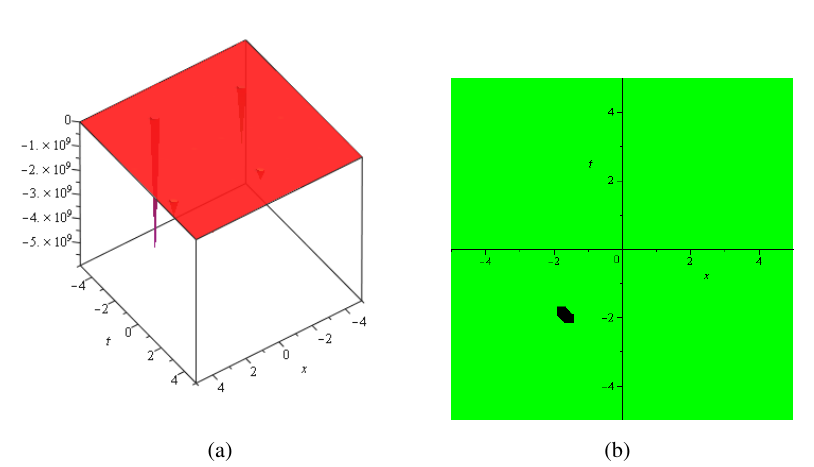
Fig. 1 Graphics of the solution equation (14) ( u 5 ( x , t ) ) corresponding to the values β = 3 , α = 4 , σ = 2 , A = 2 . 65 , p = 1 , q = 0 . 9 , b 0 = 1 and ξ 0 = − 0 . 5 (a) 3D plot and (b) contour plot.